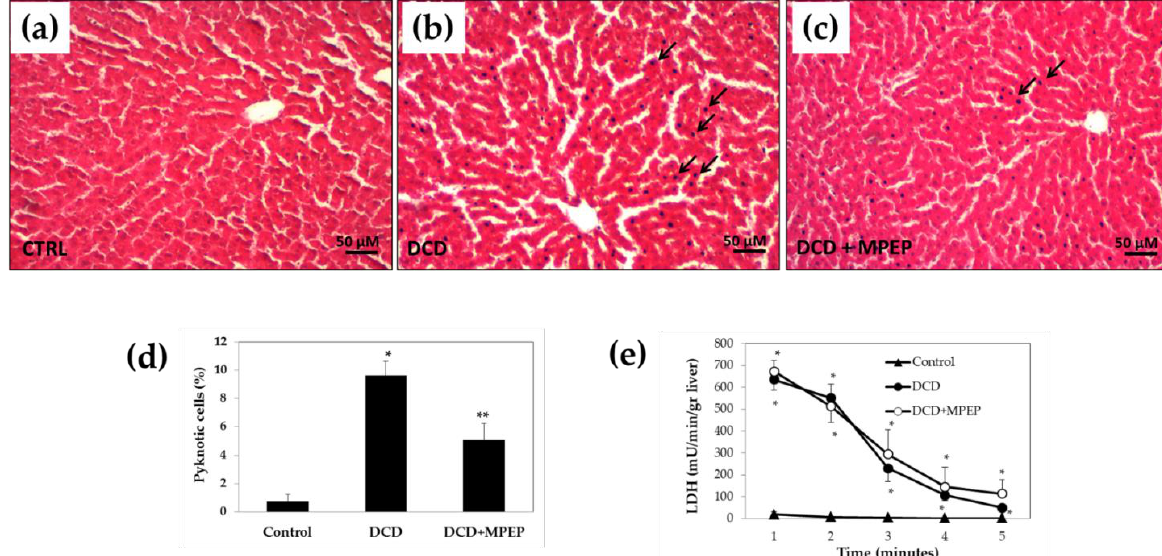
Figure 6. Representative photomicrographs of the morphology (hematoxylin and eosin staining) of DCD livers after cold storage (22 h in UW solution). ( a ) Control animals underwent cold storage; ( b ) in the DCD group, the livers, after 30 min warm ischemia, were submitted to cold storage. ( c ) In the DCD-MPEP group, the drug (10 mg/Kg) was administered 30 min before the portal clamping and added to the UW solution (3 µM). ( d ) Pyknotic cells at the end of cold storage . ( e ) LDH release during washout. Arrows: pyknotic nuclei; scale bar: 50 μm. The results are reported as the mean ±SE. * p < 0.05 versus control; ** p < 0.05 versus DCD.